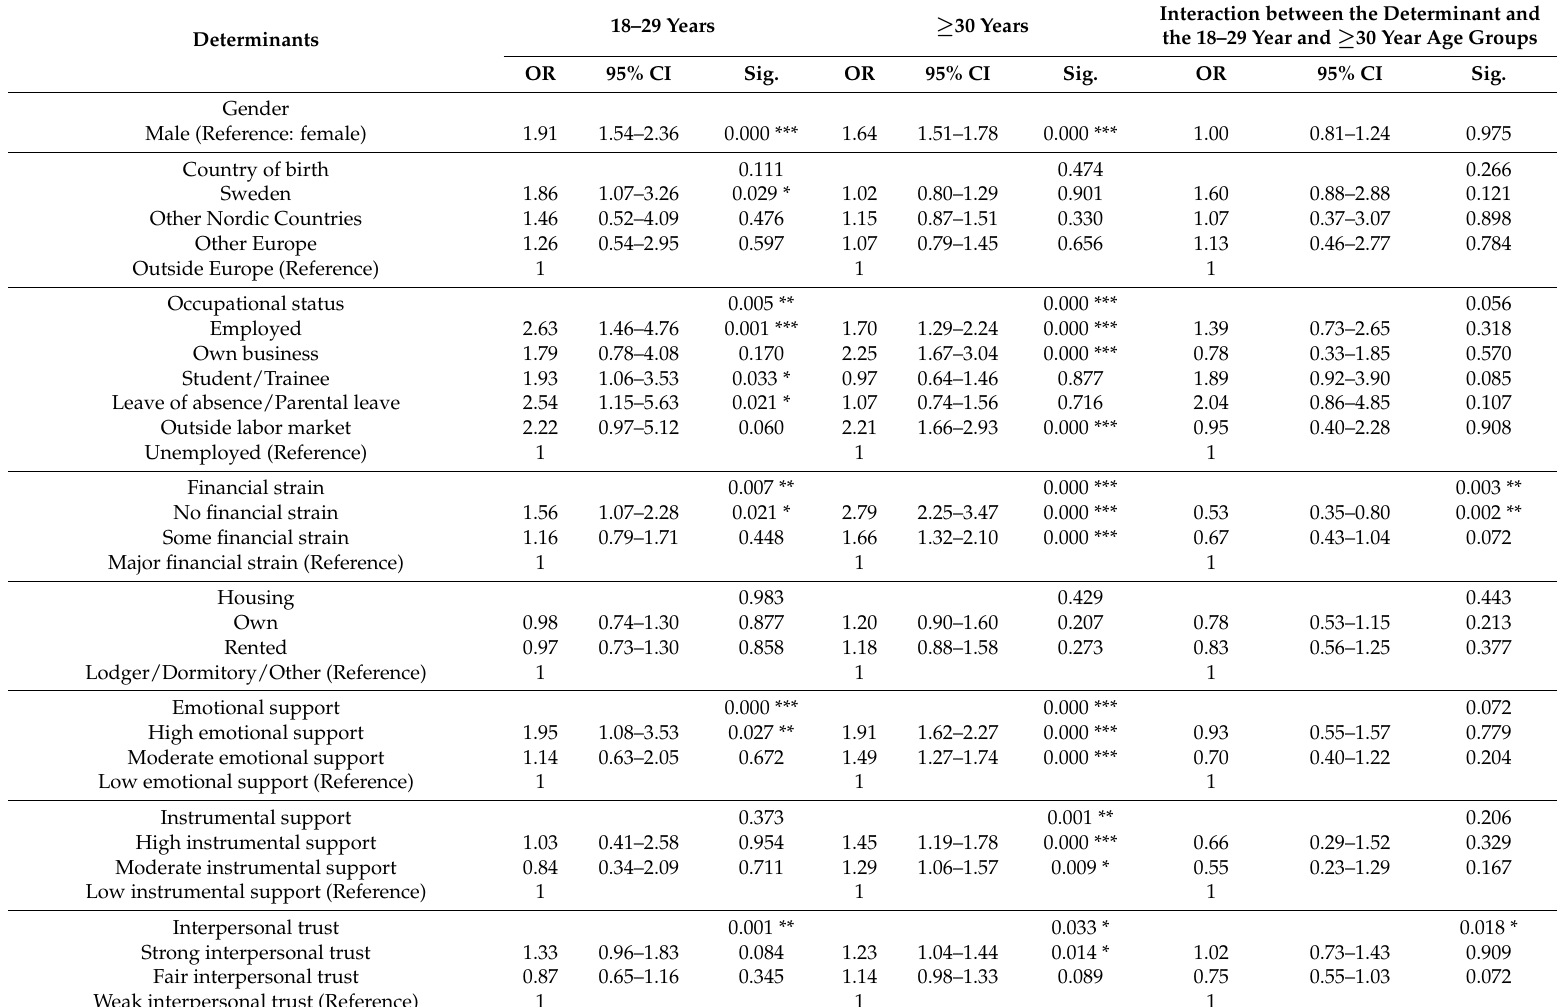
Table 1. Determinants for stable mental health in the 18–29 years and 30 years and older age groups.